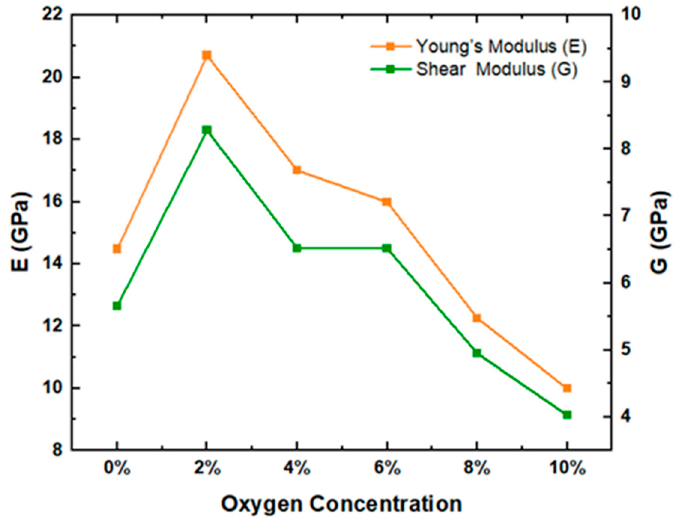
Figure 5. Young’s modulus and shear modulus in the model.